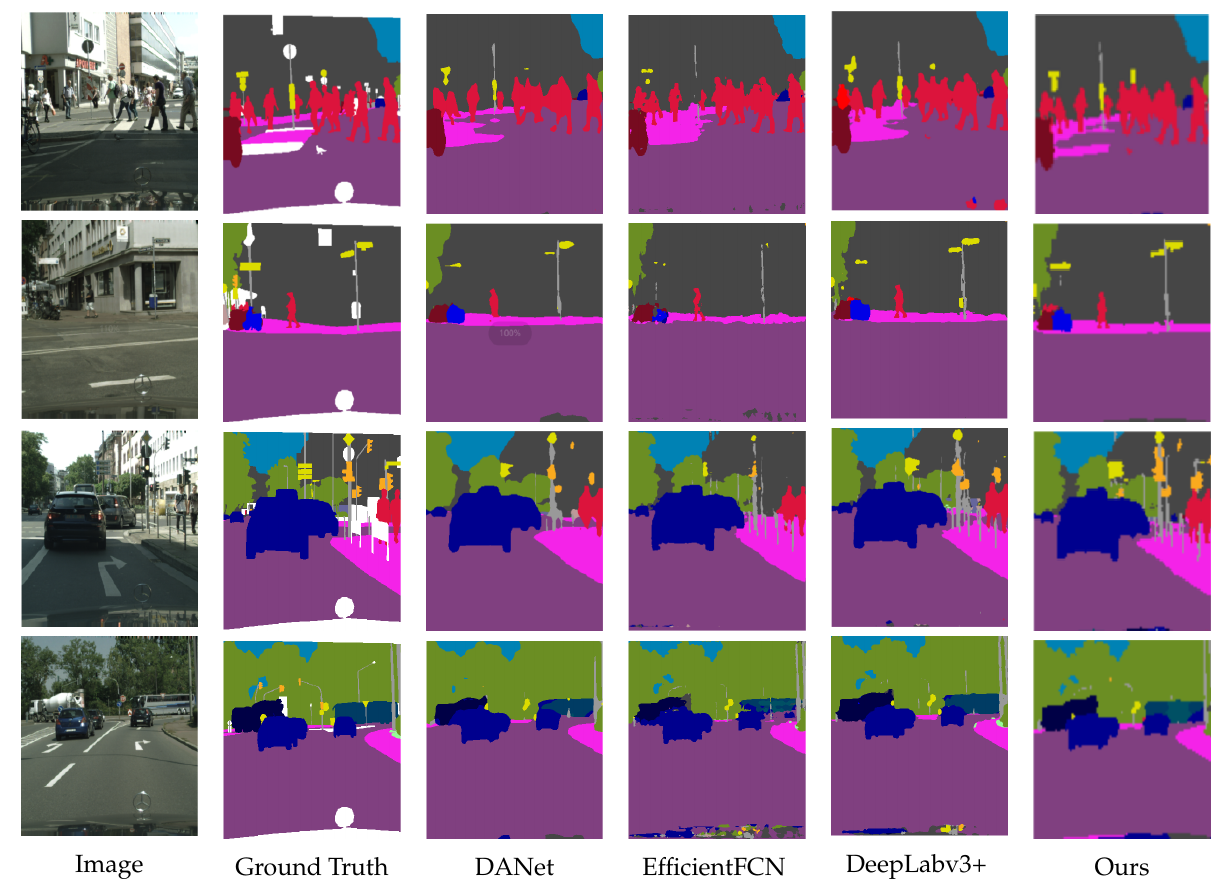
Figure 8. Visual comparison of cityscapes dataset. Table 6. Compared with transformer